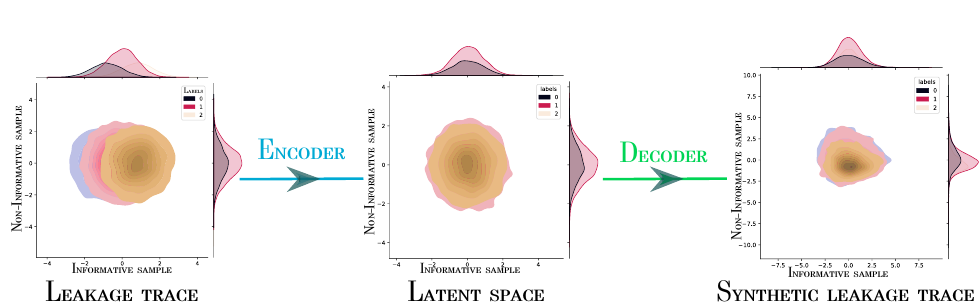
Figure 8: Evolution of the distributions over the cVAE-SA model when an unsuccessful attack is performed ( F 9